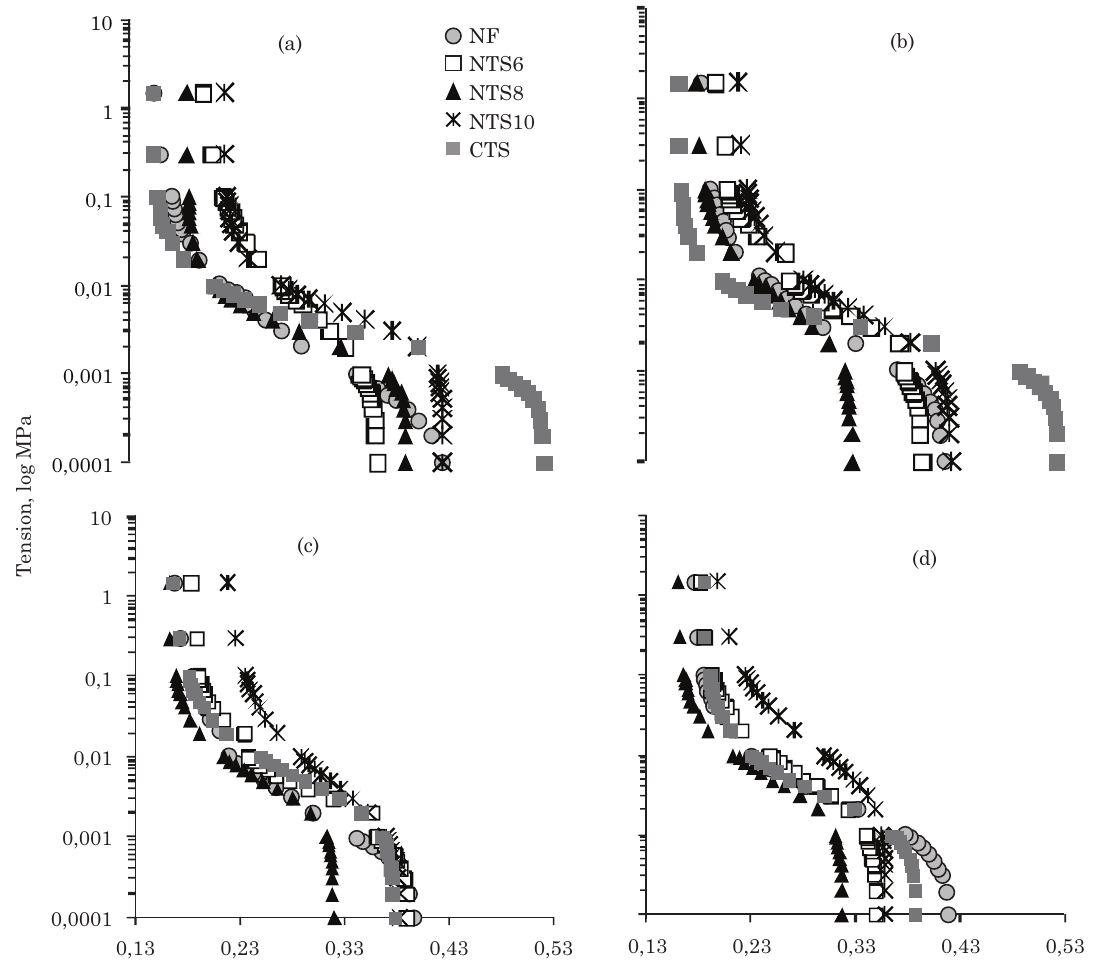
Figure 1. Water retention curves of a Red Oxisol in different layers. (a) 0-0.05 m, (b) 0.05-0.10 m, (c) 0.10-0.20 m and (d) 0.20-0.30 m. 2008/09 growing season – NF: native forest, NTS5: five-year no-tillage, NTS7: seven-year no-tillage, NTS9: nine-year no-tillage, and CTS: conventional tillage